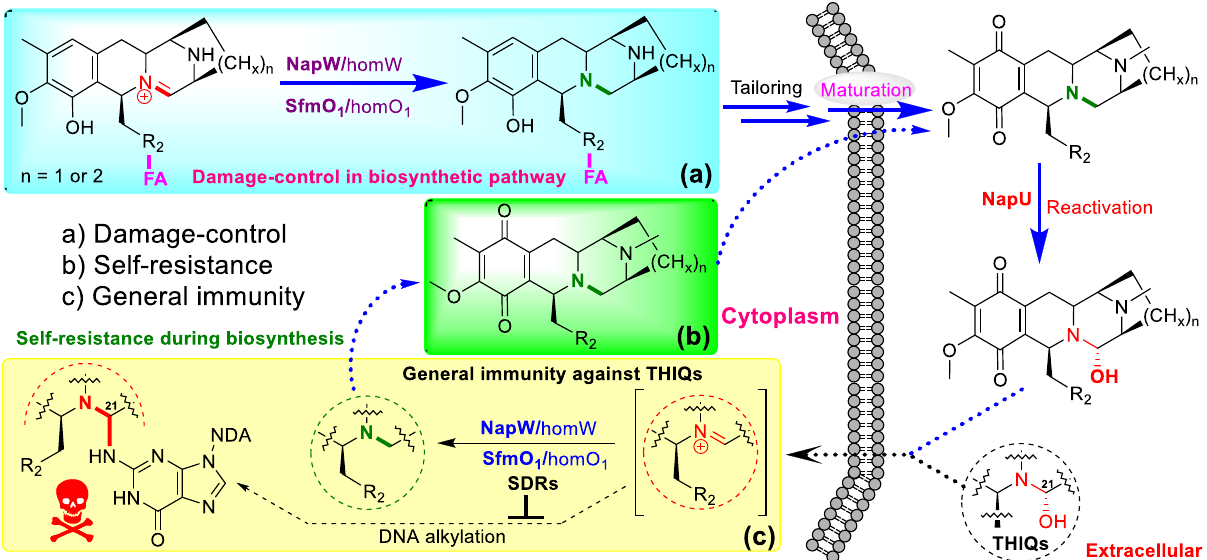
Fig. 7 Summary of the multi-level resistance model involved in NDM and SFM biosynthesis. a Damage-control process in secondary metabolic pathway controls the ef fi ciency of biosynthetic machinery. b Self-resistance during biosynthesis by NapW-homologs ensures the safety of antibiotic-producing strains. c General immunity against THIQs is not only involved in antibiotic-producing hosts, but also exists in non-antibiotic-producing microbes containing